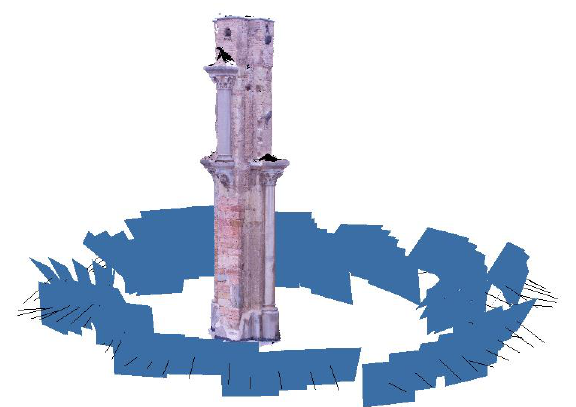
Figure 7. Digital photographic restoration of one of the central columns of the